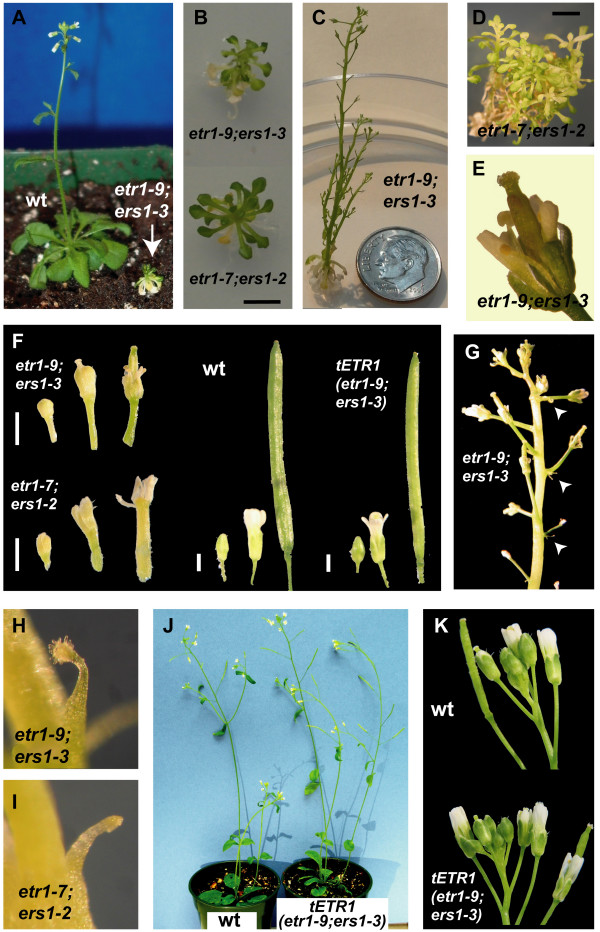
Light-grown etr1-9;ers1-3 mutant plants display multiple effects upon growth and development. (A) Comparison of 5-week-old wild type (wt) and etr1-9;ers1-3 double mutant. (B) Comparison of 5-week-old etr1-9;ers1-3 and etr1-7;ers1-2 double mutants. Scale bar = 5 mm. (C) Inflorescence of 7-week-old etr1-9;ers1-3 mutant. Coin for scale = 18 mm. (D) 7-week-old etr1-7;ers1-2 mutant plant that has not bolted. Scale bar = 5 mm. (E) Flower of etr1-9;ers1-3 mutant plant, showing reduced sepals, petals, and stamens compared to the central carpels. (F) Floral phenotypes of adult plants. Flowers of equivalent age are shown. Note that the etr1-7;ers1-2 flowers arrest at an earlier developmental stage than the etr1-9;ers1-3 flowers. No defects in flower development are observed in etr1-9;ers1-3 transformed with wild-type ETR1 (tETR1). Scale bar = 1 mm. (G) Location of filamentous structures on the inflorescence of the etr1-9;ers1-3 mutant. (H) and (I) Close-ups of filamentous structures found on etr1-9;ers1-3 and etr1-7;ers1-2 mutants, respectively. (J) Phenotype of etr1-9;ers1-3 transformed with ETR1 (tETR1) in comparison to wild type (wt). Six-week-old plants are shown. (K) Inflorescence of the etr1-9;ers1-3 mutant transformed with ETR1 (tETR1) compared to wild type. Note that the transformed mutant no longer produces filamentous structures.